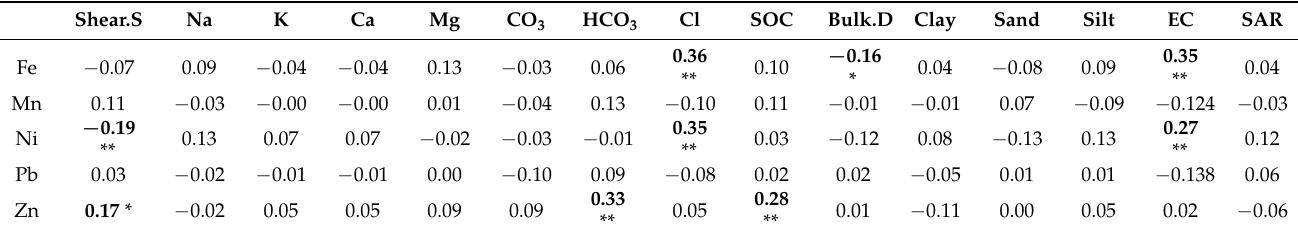
Table 2. Pearson correlation coefficients between soil parameters and soil heavy metals.